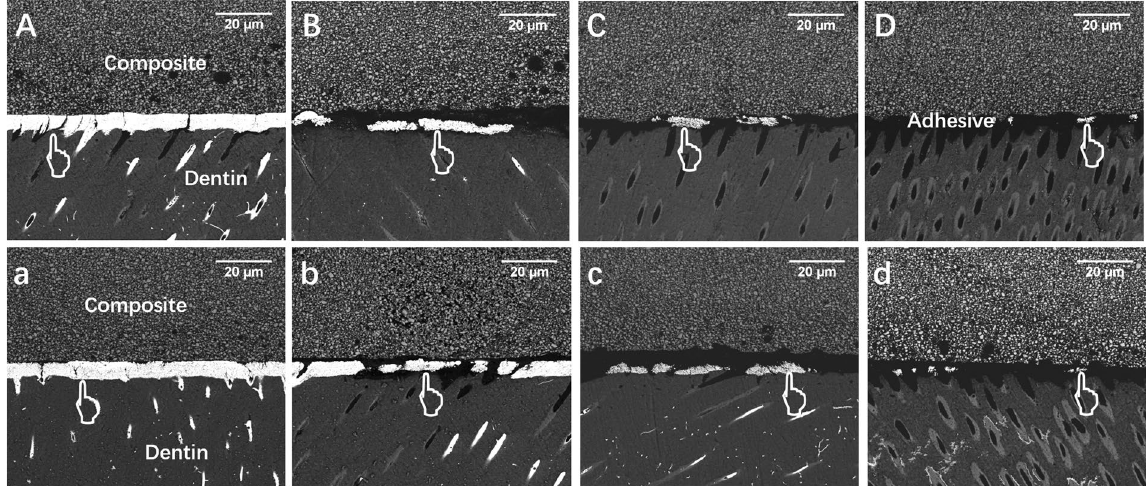
Figure 6. Representative FESEM images (3000 × ) of nanoleakage expression from different groups. Bonded interface of the immediate groups ( A–D ) and one-month collagenase-aged groups (a–d): ( A ,a) control group; quercetin-doped adhesive groups at the concentration of ( B ,b) 100 ug/mL, ( C ,c) 500 ug/mL and ( D ,d) 1000 ug/ mL. Pointer: silver uptake.